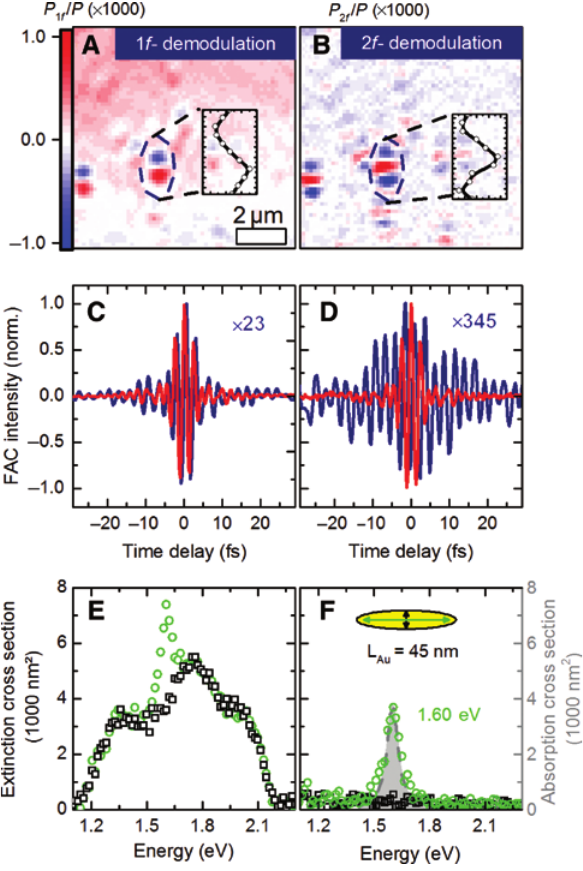
Figure 5: The demonstration of the background suppression using higher-order